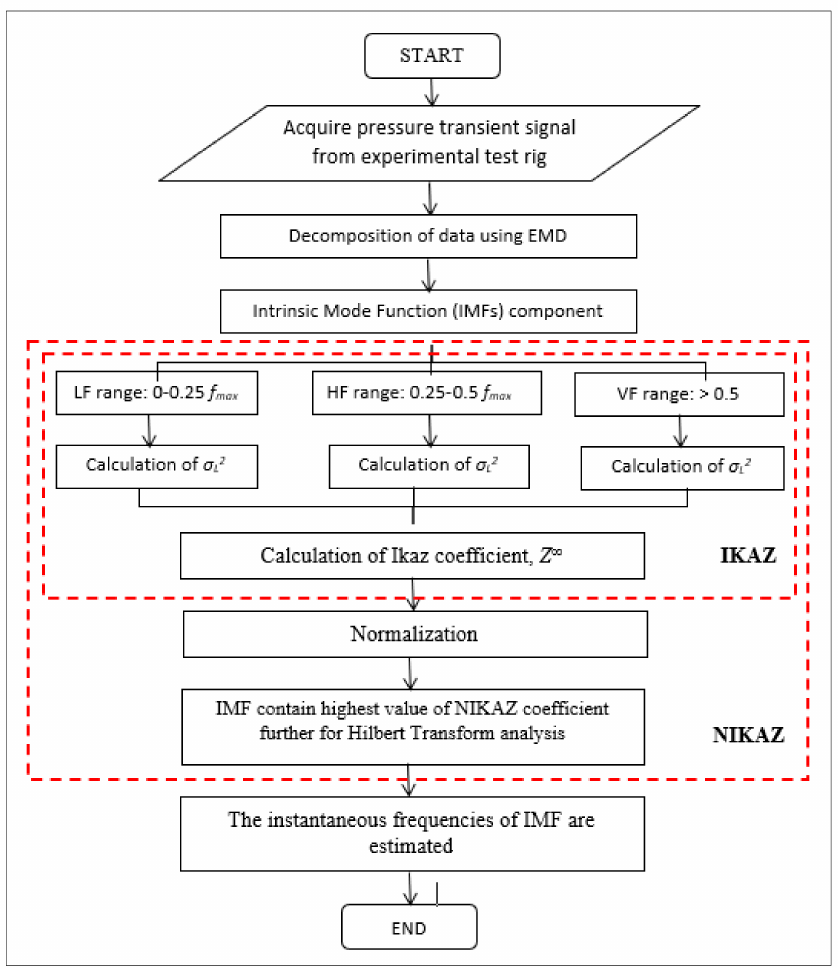
Figure 1. Flowchart of the proposed